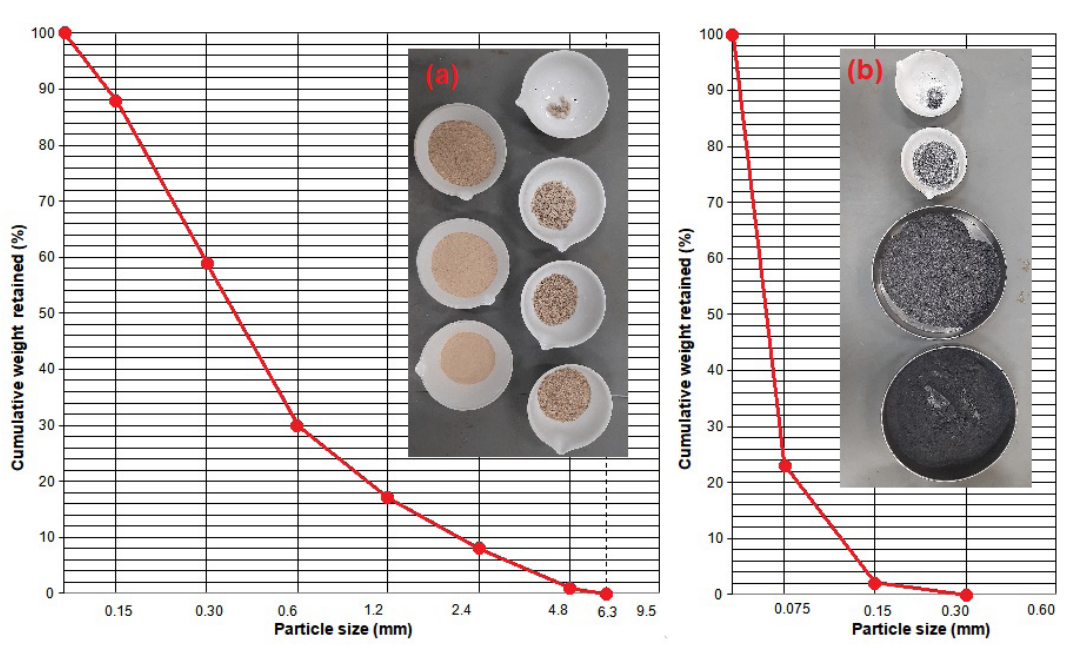
Figure 4. The granulometric curves of the sand (a) and graphite (b)